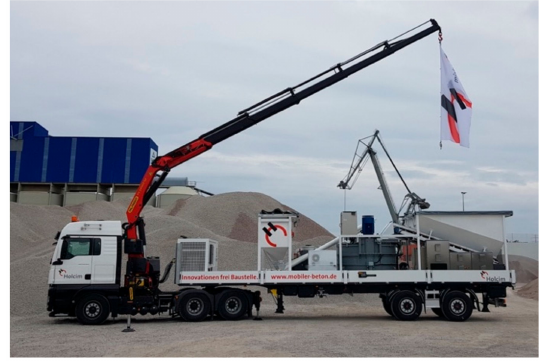
Figure 12. Truck-mounted concrete plant for ILC (courtesy: Björn